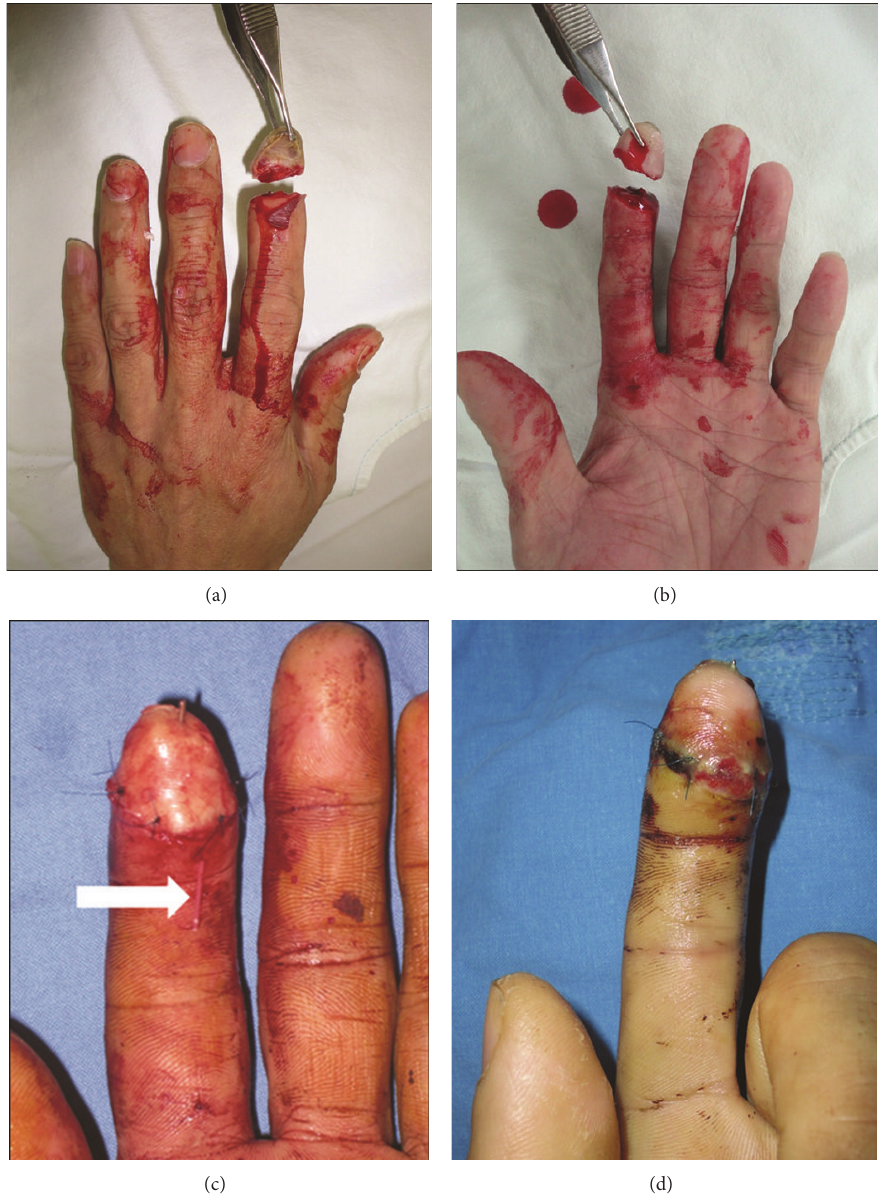
Figure 2: Details of Case 1. (a) and (b) A 46-year-old man amputated his left second finger just distal of distal interphalangeal joint. The patient had history of blunt trauma with a hammer to the same finger leaving the amputation site scarred and atrophied. (c) Immediate postoperative view. The angioneedle is located proximal to the amputated portion (arrow), which was anastomosed to the branch of central artery and functioned as a conduit for venous drainage. (d) View on postoperative day 8. The digit was replanted